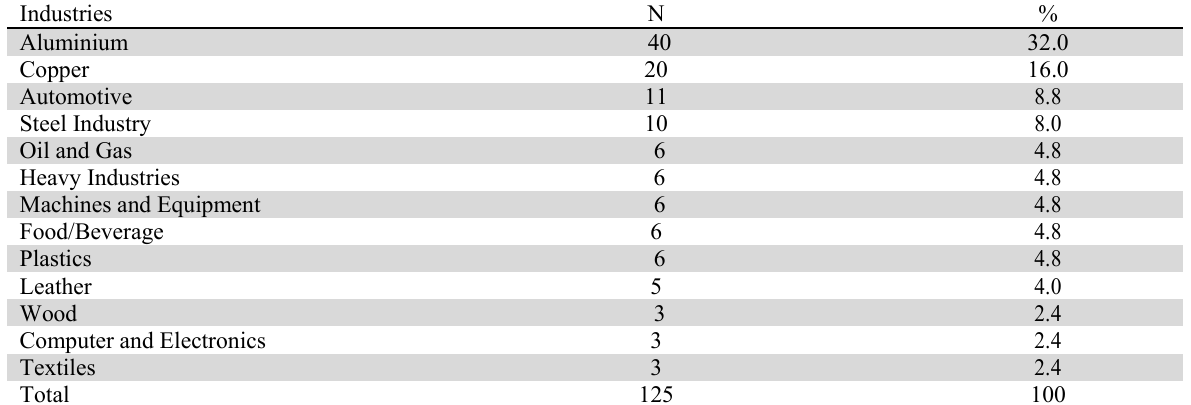
Response rate by manufacturing industries